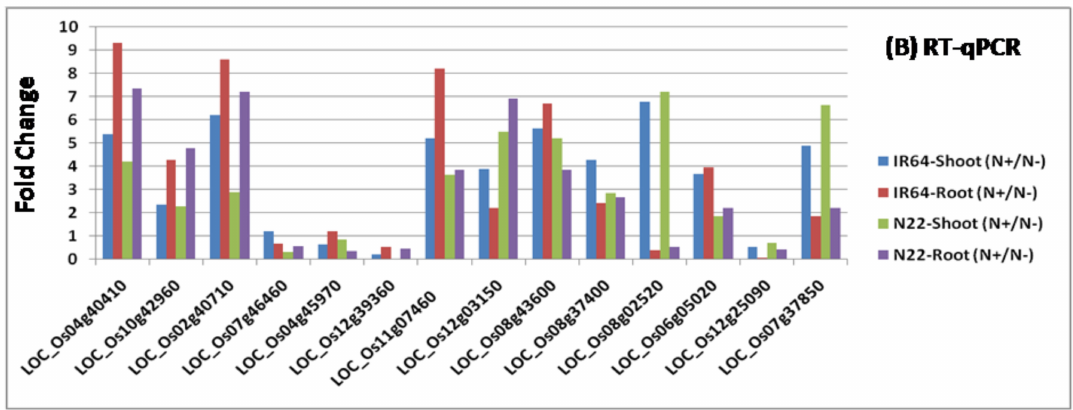
Figure 5. Validation of 14 differentially expressed genes (DEGs) identified from transcriptome analysis by q-PCR ( A ) RNA-seq based expression profiling; ( B ) q-PCR based expression